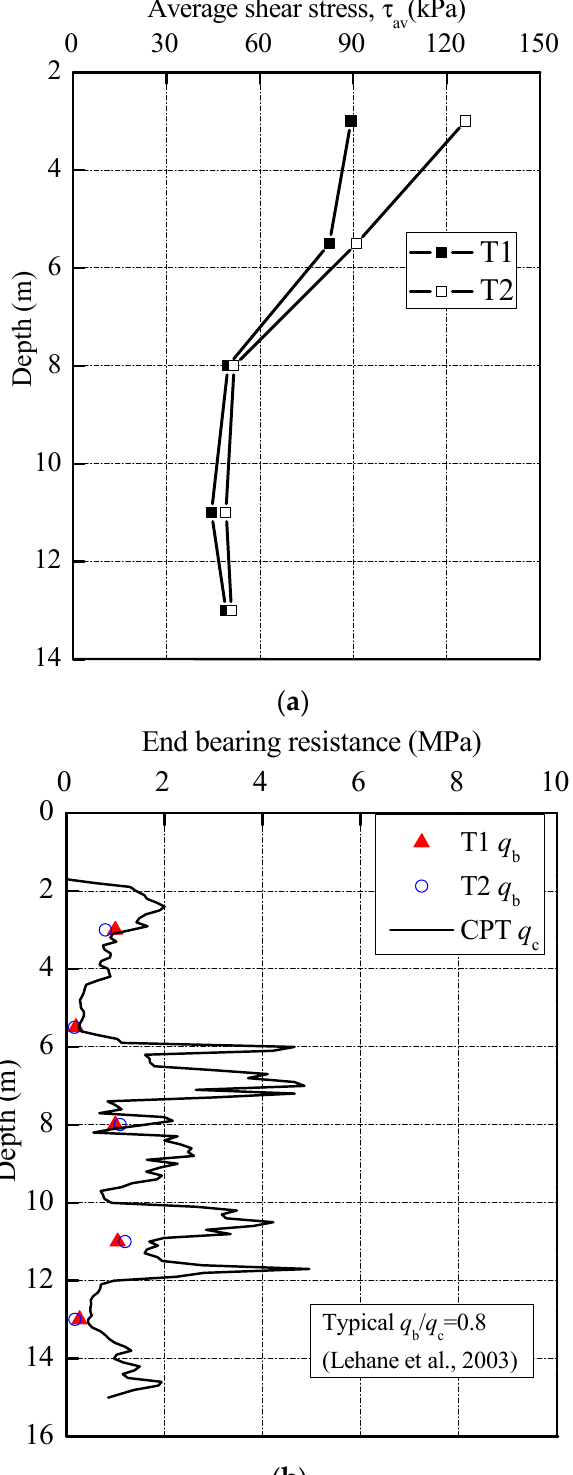
Figure 10. Pile installation stresses with depth. ( a ) Average shear stresses profile; ( b ) Average end bearing stress.